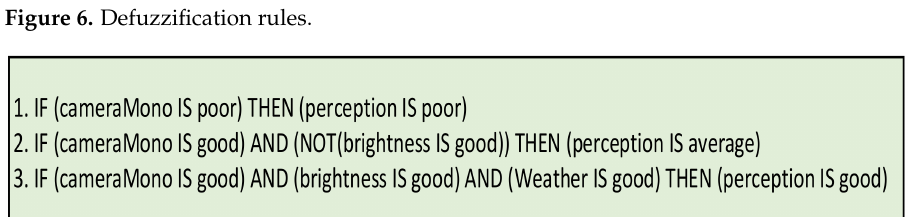
Figure 6. Defuzzification rules.